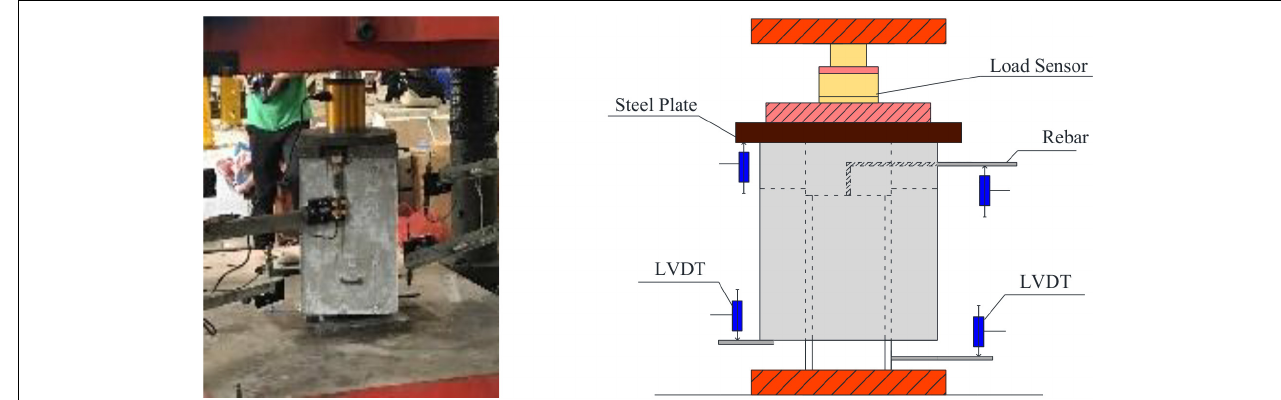
FIGURE 2 | Setup and instrumentation for push-out